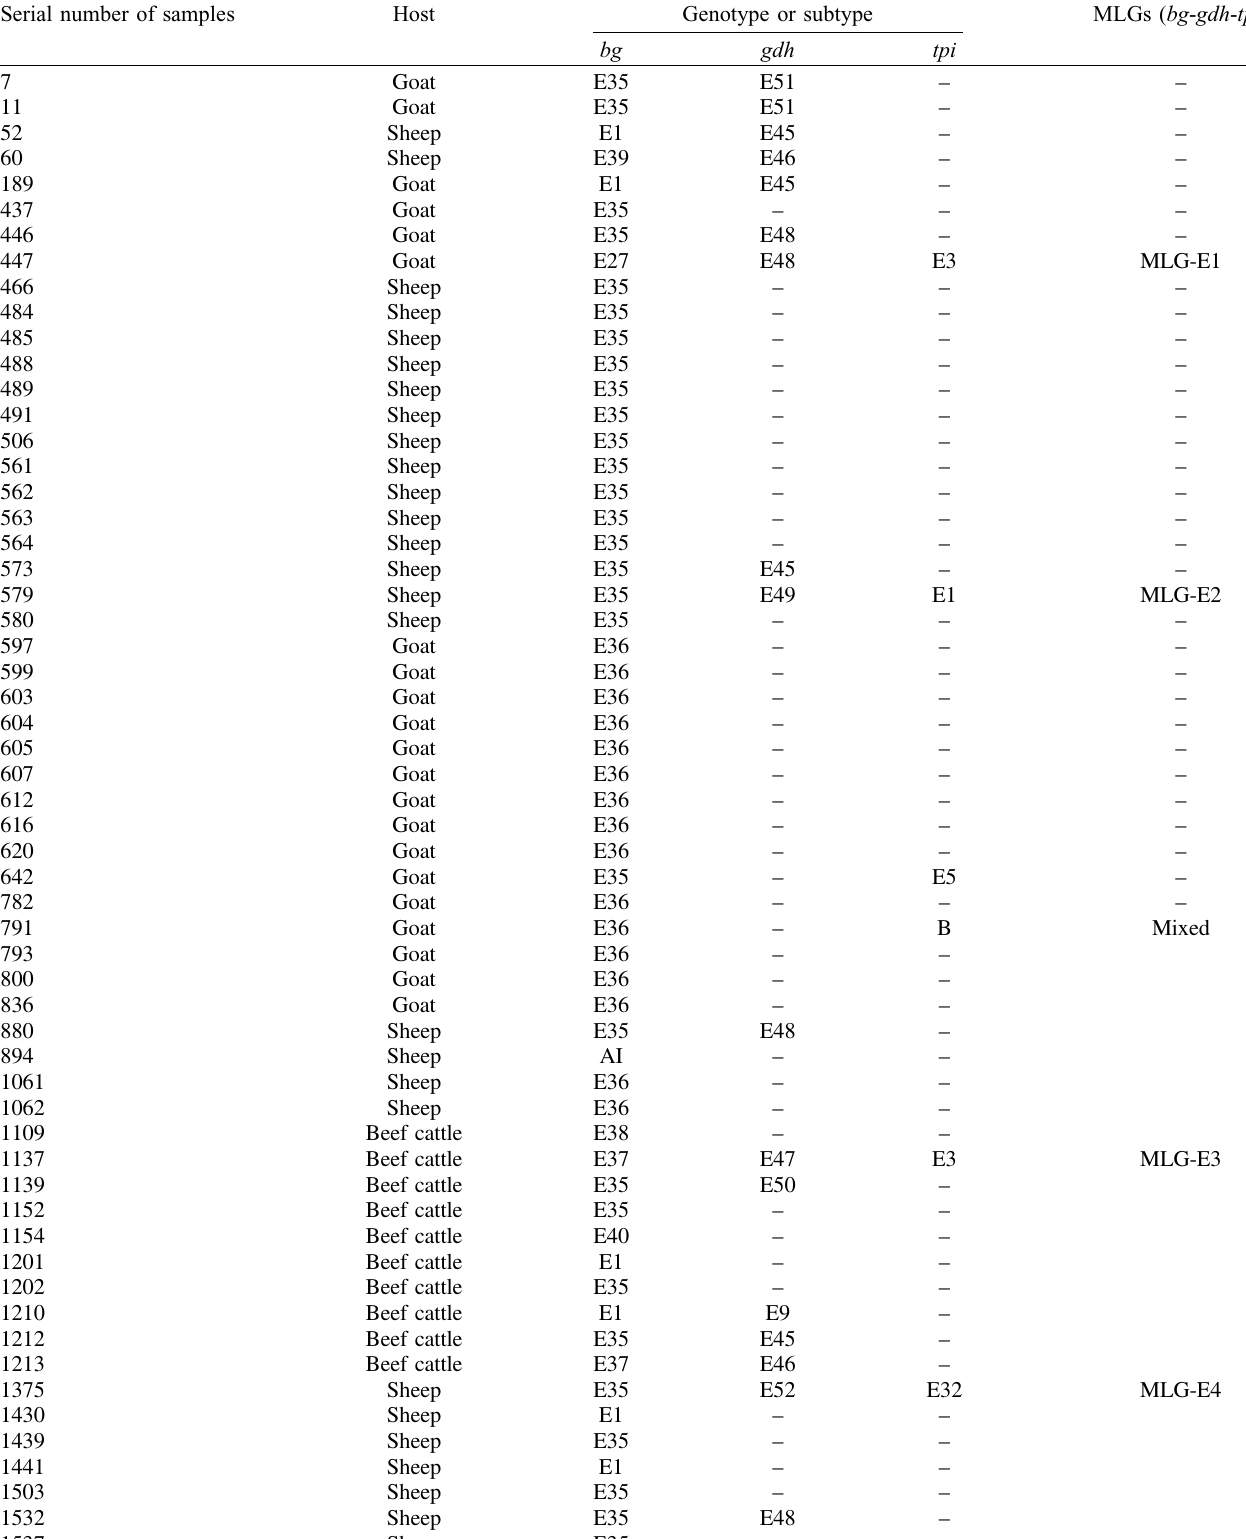
Table 4. Multilocus characterization of G. duodenalis isolates based on the beta-giardin ( bg ), glutamate dehydrogenase ( gdh ), and triose phosphate isomerase ( tpi ) genes in